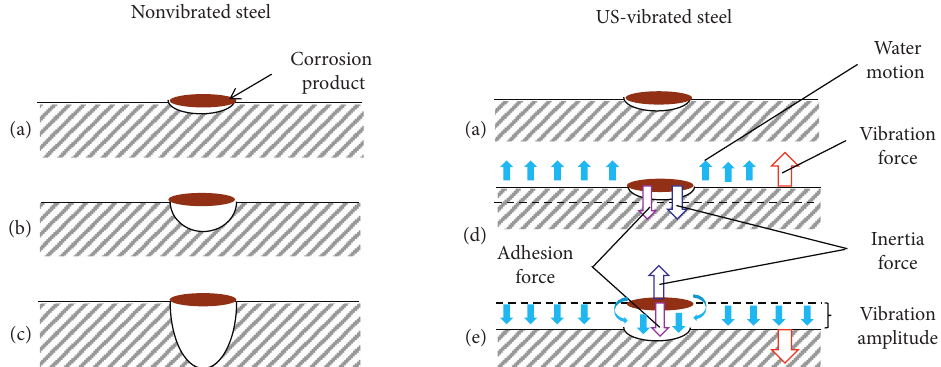
Figure 6: The scheme of pitting suppression with the application of ultrasound vibration: (a) pit nucleation; (b) metastable pitting; (c) stable pitting growth; (d, e) influence of